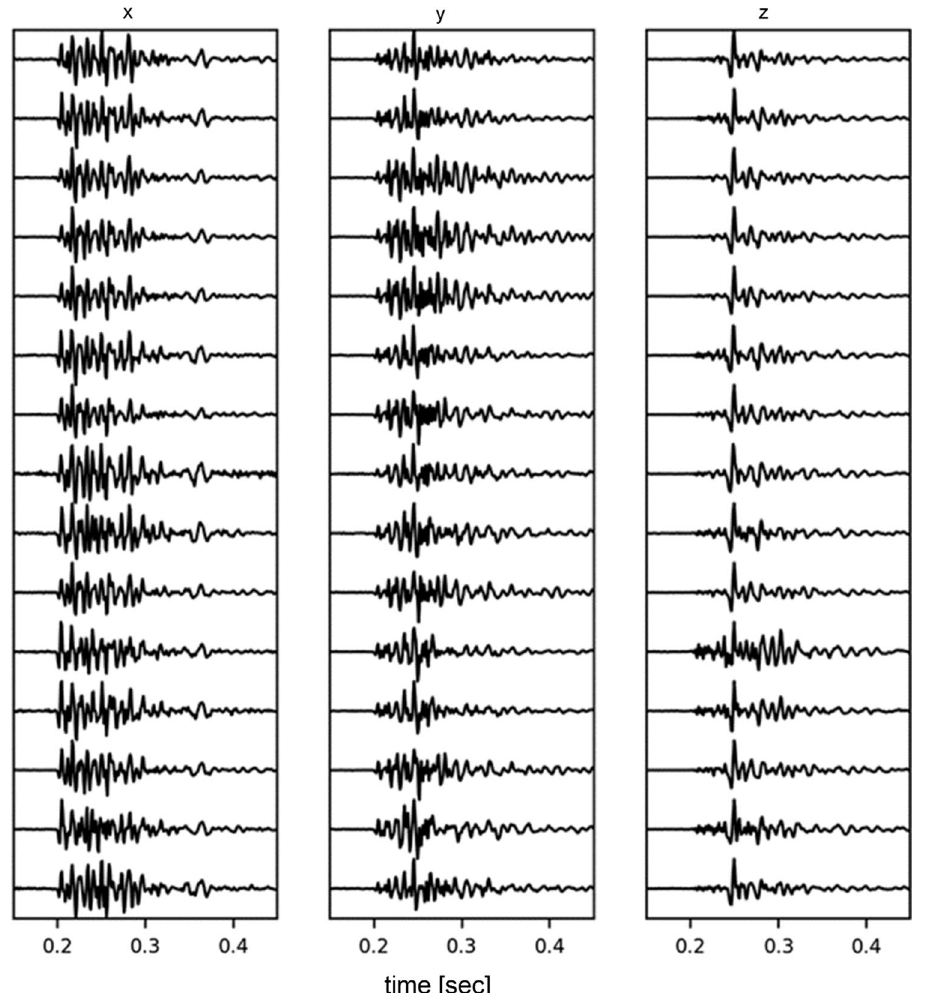
Fig. 5 A multiplet family, with the highest number of events, based on data temporary scientific monitoring network and new catalogue 2014– 2017 (adapted from Namjesnik